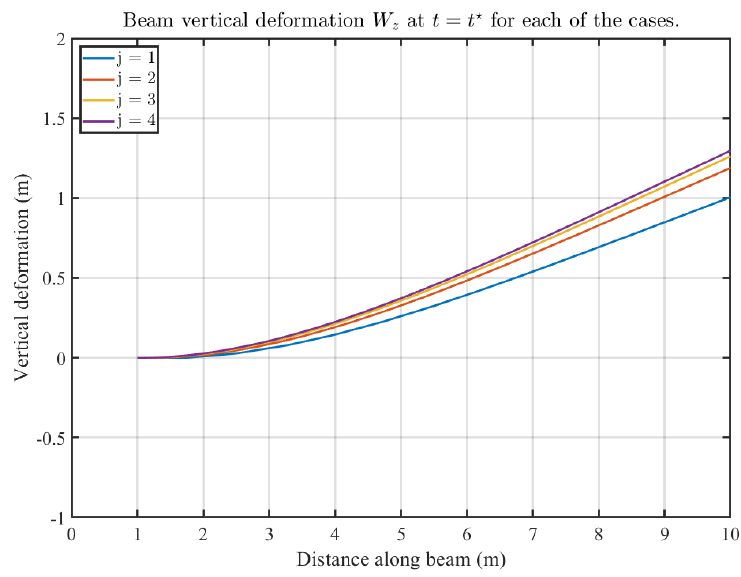
Figure 7. Beam deformation distributions for the four grid convergence study